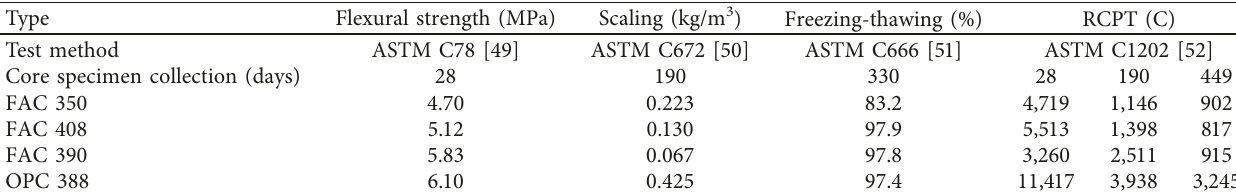
Table 9: Results of durability evaluation to improve standard mix design of concrete